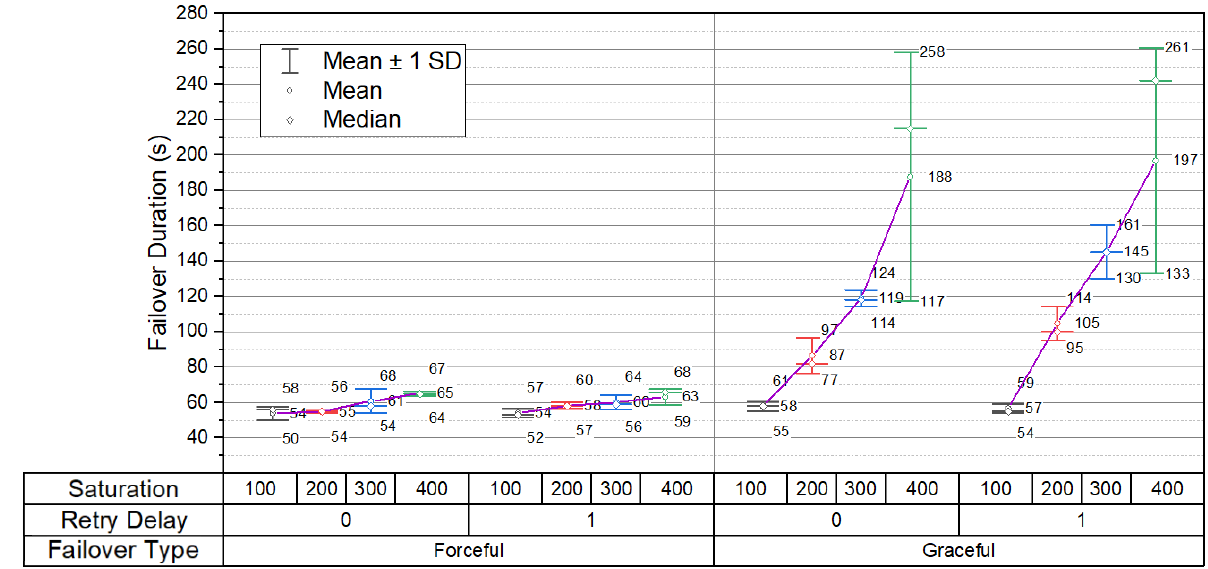
Figure 6. Dependency of failover duration on failover method, saturation and retry delay.